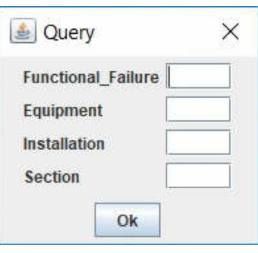
Figure 7. Initial window for input information running on Windows 10.